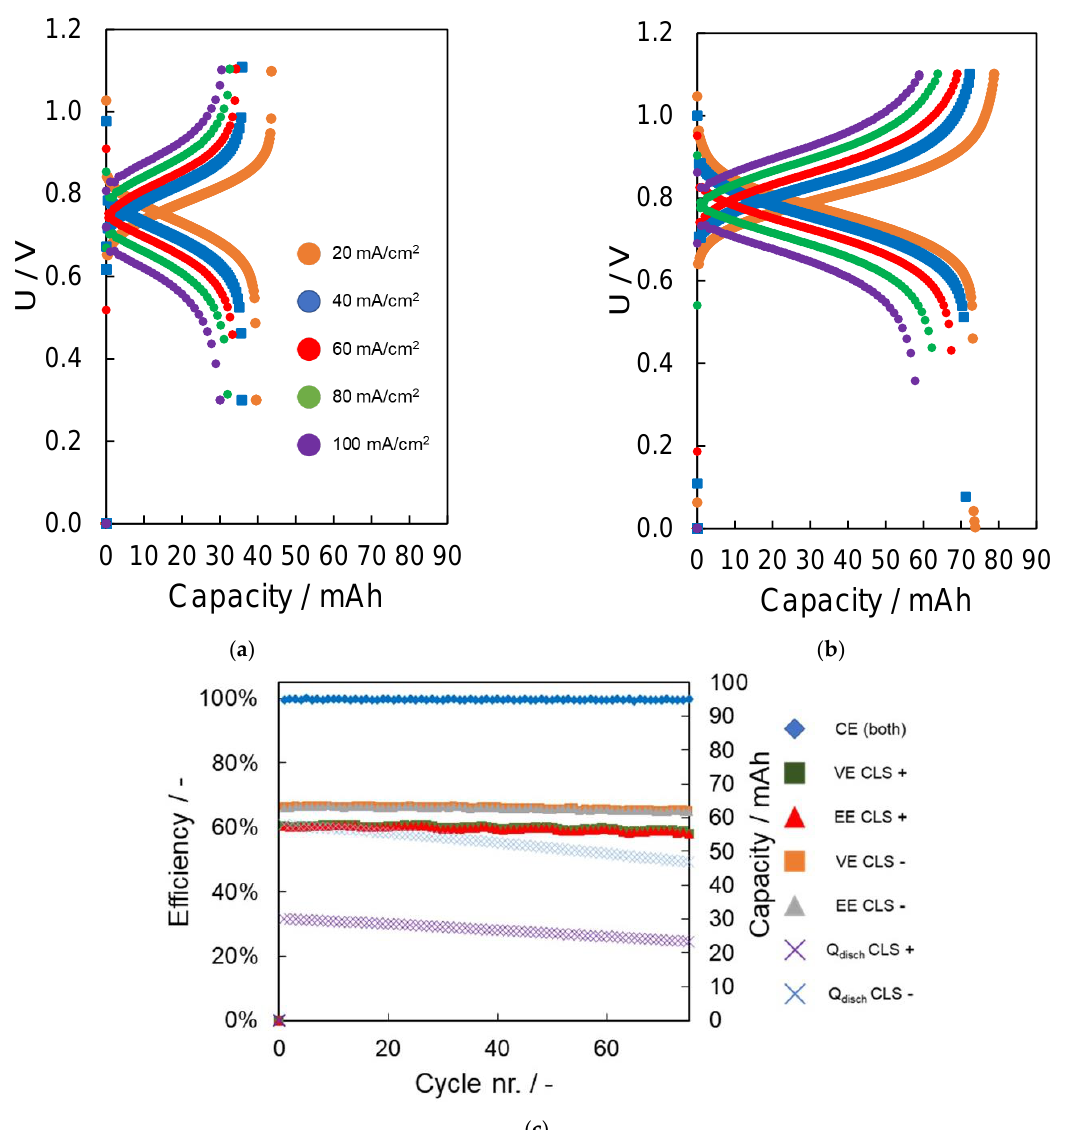
Figure 8 . Comparison of charge/discharge profiles at different current densities (20, 40, 60, 80 and 100 mA/cm 2 ) for batteries using different capacity-limiting sides (CLS): ( a ) 0.1 M AQDS in 1 M NaCl vs. 0.1 M Na 4 [Fe(CN) 6 ] in 1 M NaCl, ( b ) 0.08 M AQDS in 1 M NaCl vs. 0.2 M Na 4 [Fe(CN) 6 ] in 1 M NaCl, using pretreated Nafion 212 ® membrane. ( c ) Comparison of the voltage and energy efficiencies for both batteries in 100 cycles at 100 mA/cm 2 . Coulombic efficiency (almost equal for both batteries): blue diamond. Voltage efficiency: green and orange squares (Na 4 [Fe(CN) 6 and AQDS as CLS, respectively). Energy efficiency: red and grey triangles (Na 4 [Fe(CN) 6 and AQDS as CLS, respectively). Discharge capacity: blue and purple crosses. (Na 4 [Fe(CN) 6 and AQDS as CLS, respectively).